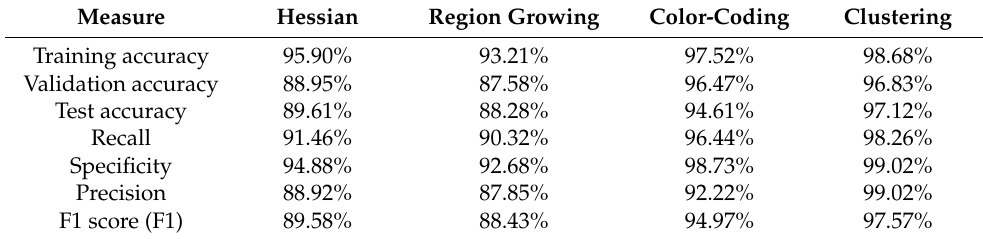
Table 5. Evaluation metrics of all methods with CNN modified with attention mechanism and LSTM.